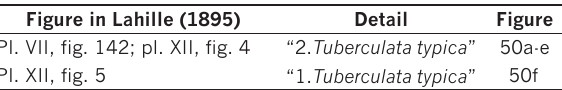
Pl. VII, fig. 142; pl. XII, fig.